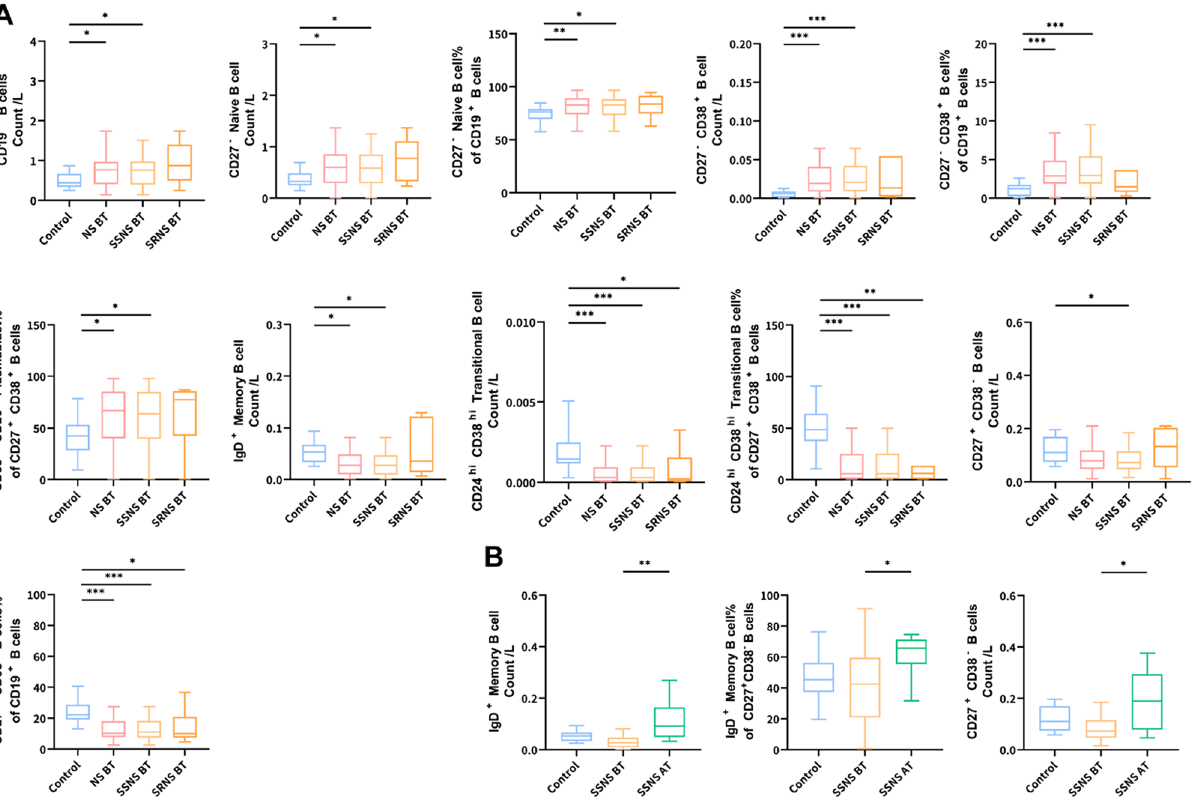
changes of B cells in peripheral blood of patients with nephrotic syndrome before and after treatment. Control normal control (n = 30), NS nephrotic syndrome (n = 85), SSNS steroid-sensitive nephrotic syndrome (n = 59), SRNS steroid-resistant nephrotic syndrome (n = 26), BT before treatment, AT after